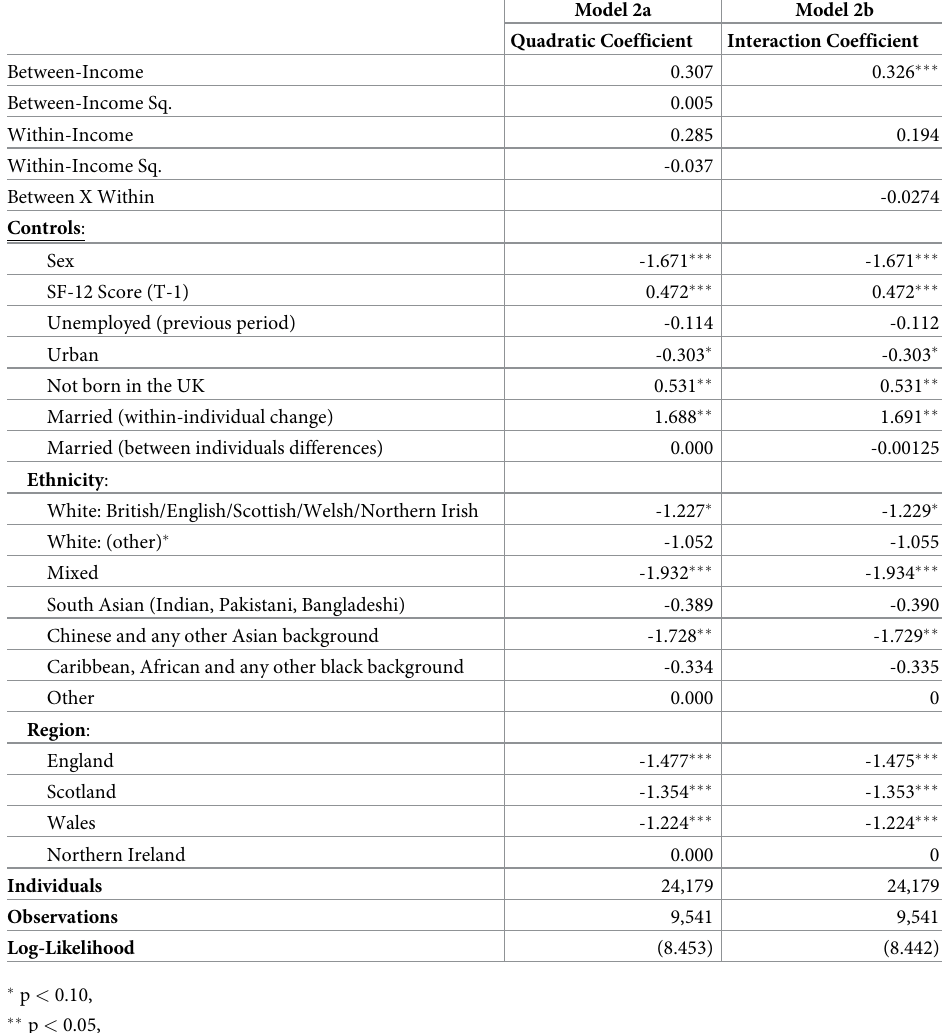
Table 6. Within-between quadratic (Model 2a) and interaction (Model 2b) models SF-12 MCS associations by net equivalised household income